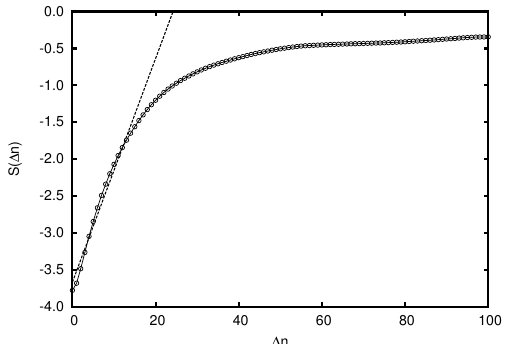
Fig. 7. The power spectrum of wind speed time series as a function of frequency at location Latitude: 34.98420 Longitude: -104.03971. Broadband and exponential decay of the power with frequency are 0 . 008 . ± typical characteristics of chaotic signals.